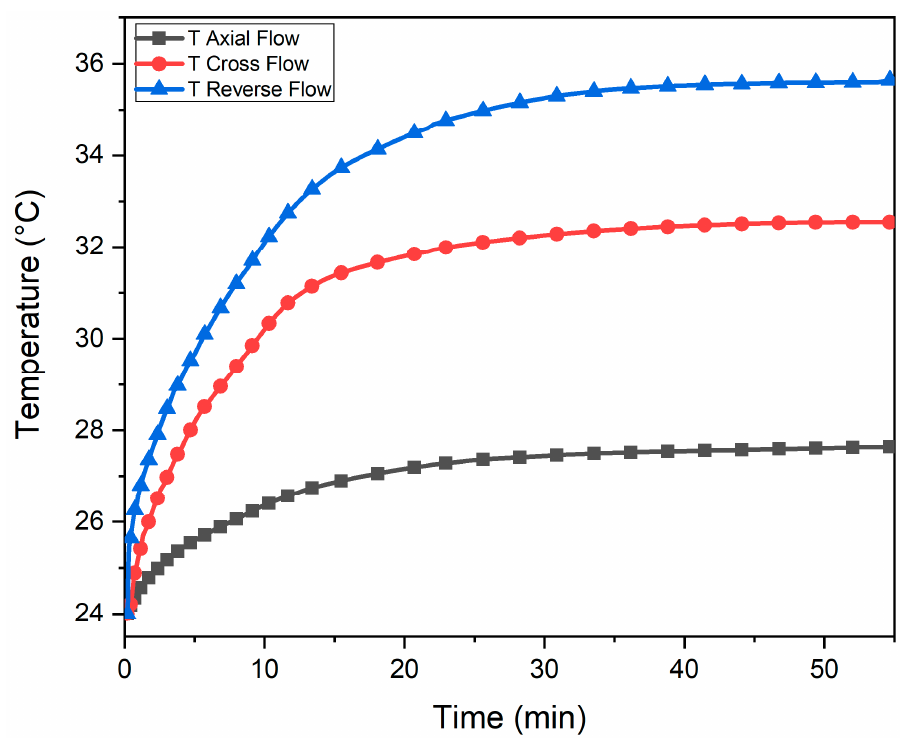
Figure 18. Cavity configuration comparison at a power level of 30 W.